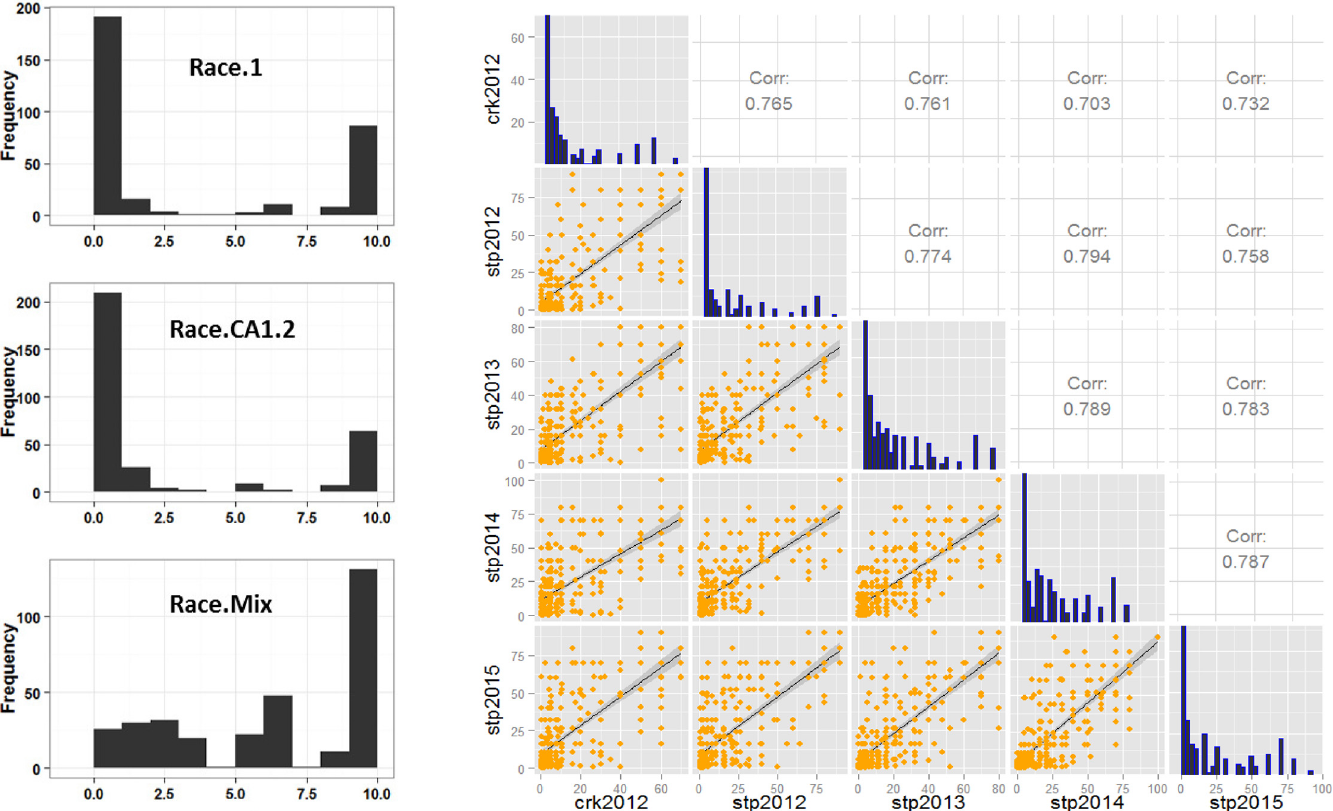
Fig 1. Seedling disease levels and field disease (coefficient of infection, COI) correlations. (a) Left (black and white) panel showing seedling disease distributions; X-axis represents linearized 0 – 9 scales; (b) Right (orange and blue) panel showing field disease correlations. Diagonals are histogram for each environment (Crookston CRK12,Saint Paul StP12-15).